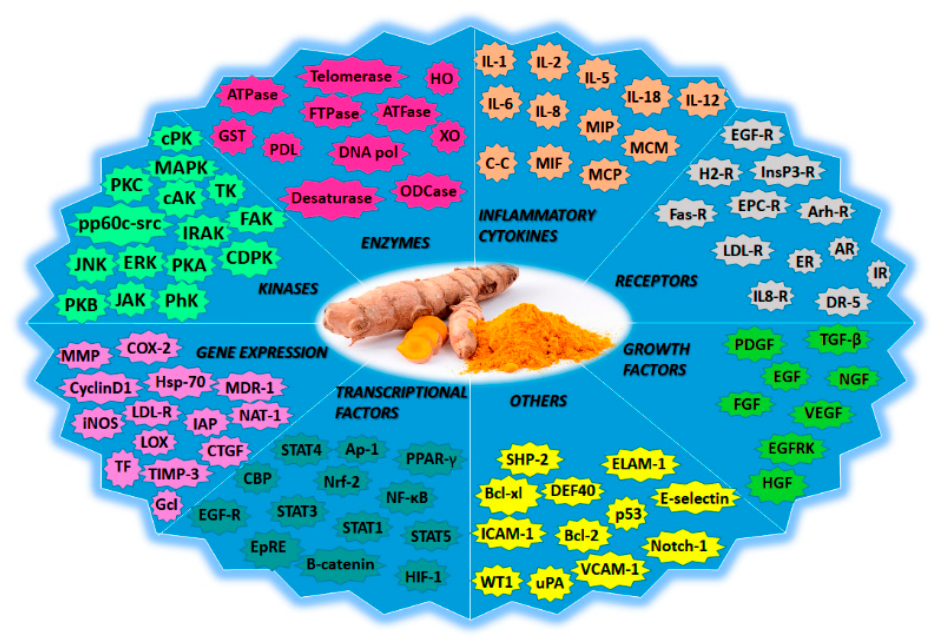
Figure 7. Curcumin is a pleiotropic agent with multiple molecular targets. This molecule could modify the expression of genes, inflammatory cytokines, transcriptional and growth factors, enzymes, and receptors, among others. Adapted with permission from [26]. 2007, Springer